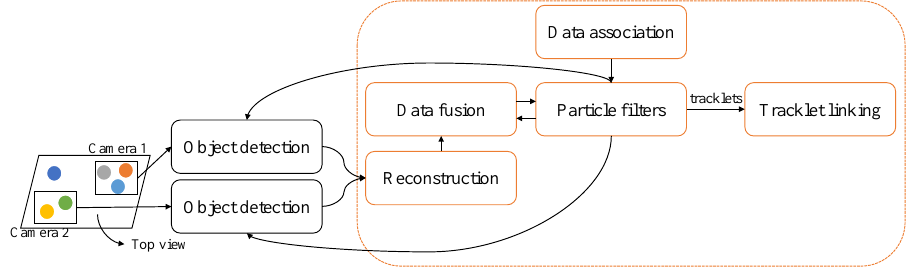
Figure 15. An example of a model of Tracklet association [77] with the MOT15 benchmark